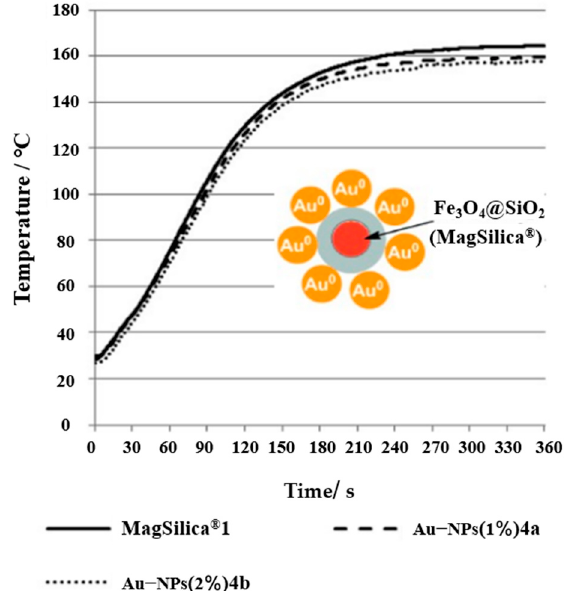
Figure 10. Gold nanoparticle attachment and heating curve